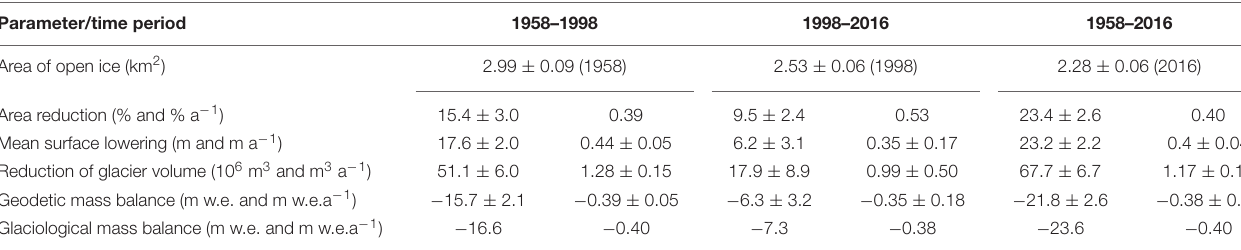
TABLE 3 | Area, volume, and mass balance of the Central Tuyuksu glacier. Parameter/time